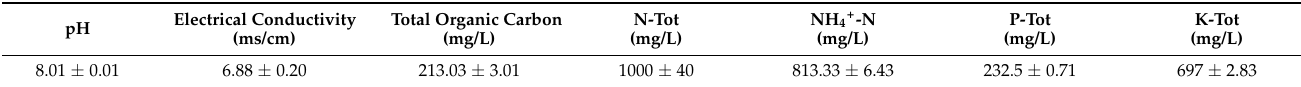
Table 1. Characteristics of digested pig slurry.